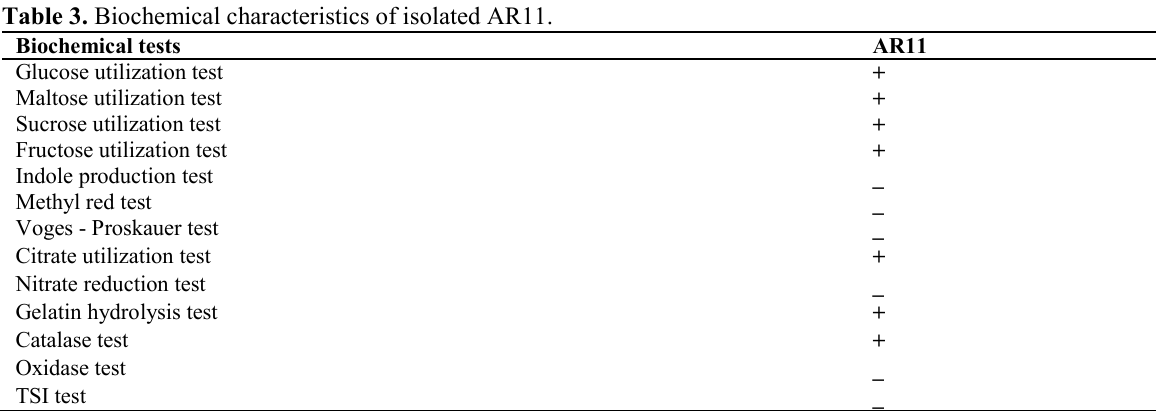
Table 3. Biochemical characteristics of isolated AR11.